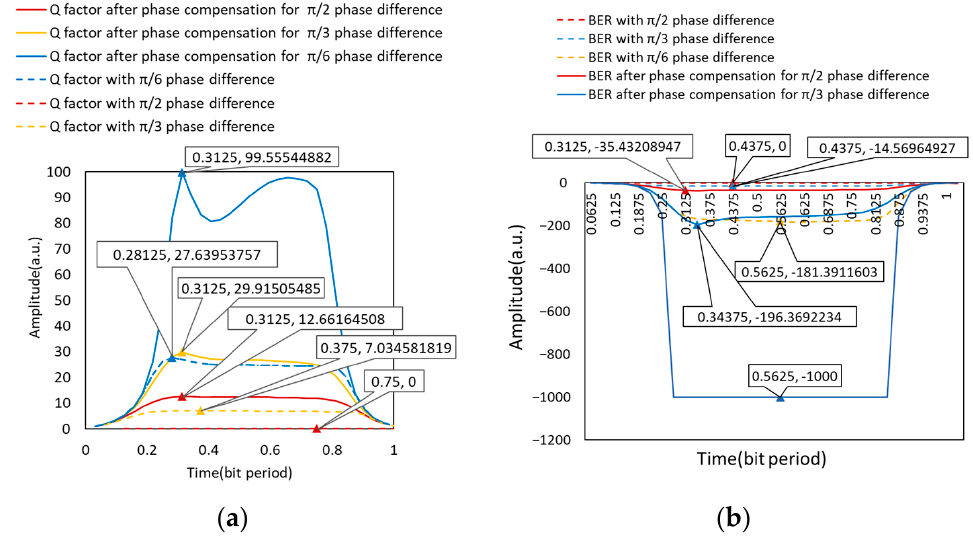
Figure 9. Communication quality with the phase difference in the transmission of two optical signals: ( a ) Q factors with the phase difference; ( b ) BER with the phase difference.